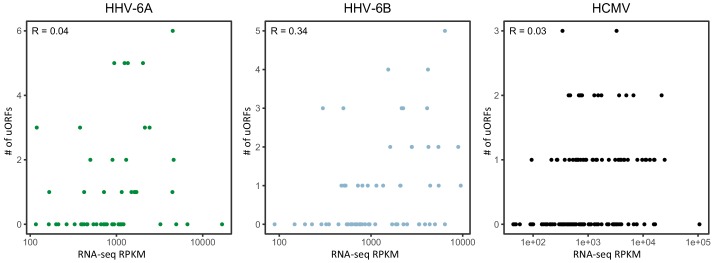
Number of uORFs as a function of RNA abundance.Scatter plots showing the number of uORFs of each main ORF (Y axis) as a function of the RNA expression level of the same ORF as measured by RNA-seq (X axis). Pearson's correlation coefficient R is displayed for each virus.